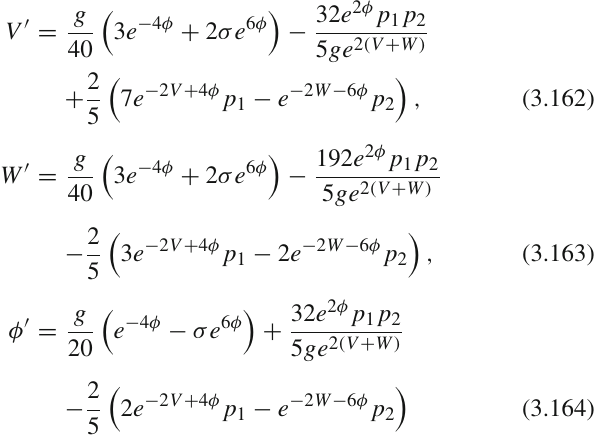
, − 1 , − 1 , − 2 , 23 22 21 41